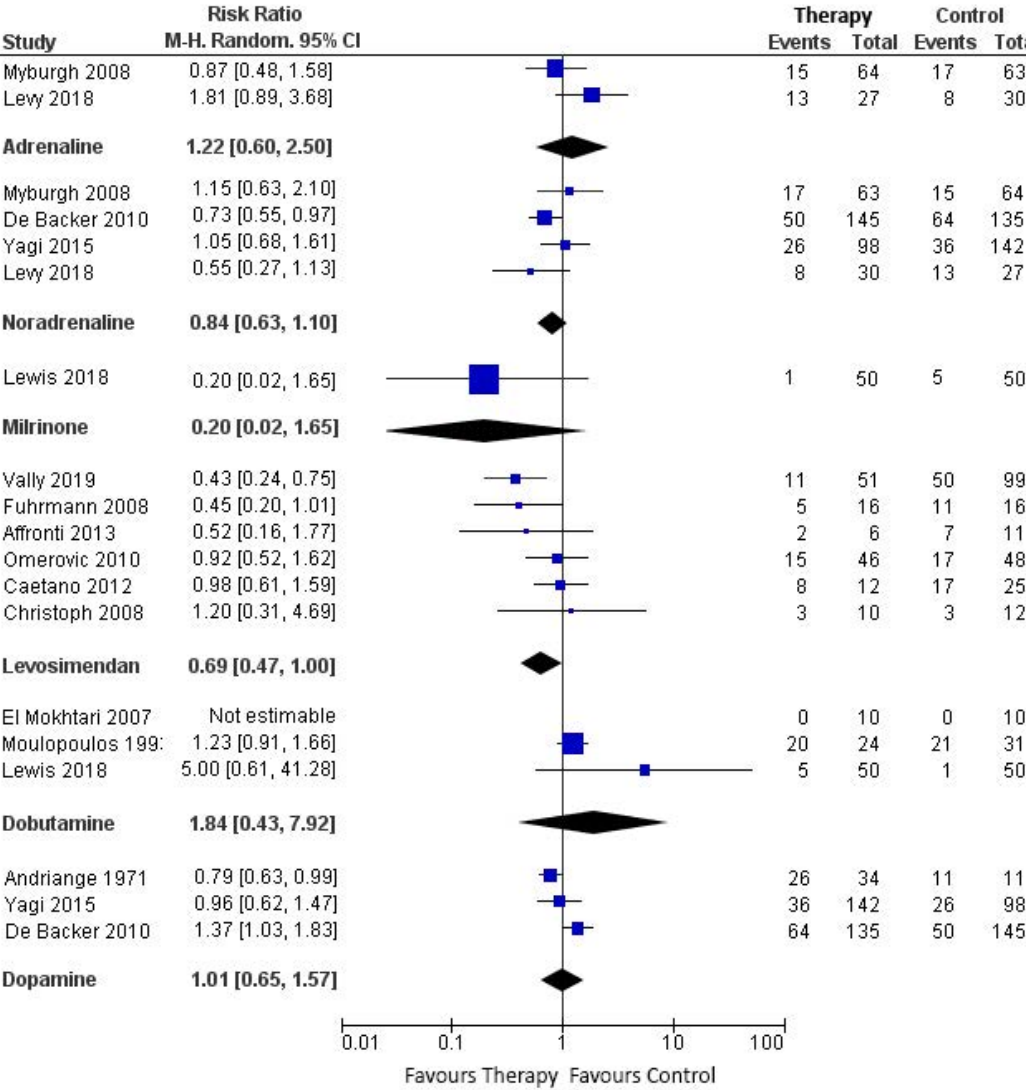
Figure 2. Forest plot demonstrating short-term ( < 90 day) mortality of cardiogenic shock patients treated with a vasopressor / inotrope versus a constructed control group.